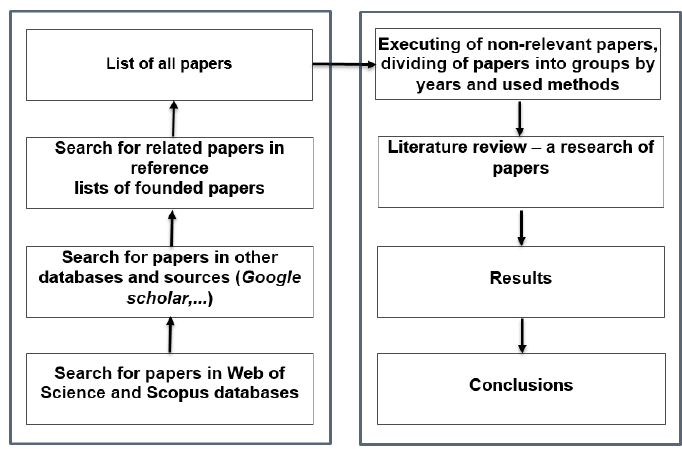
Figure 1. Flowchart of the literature review procedure